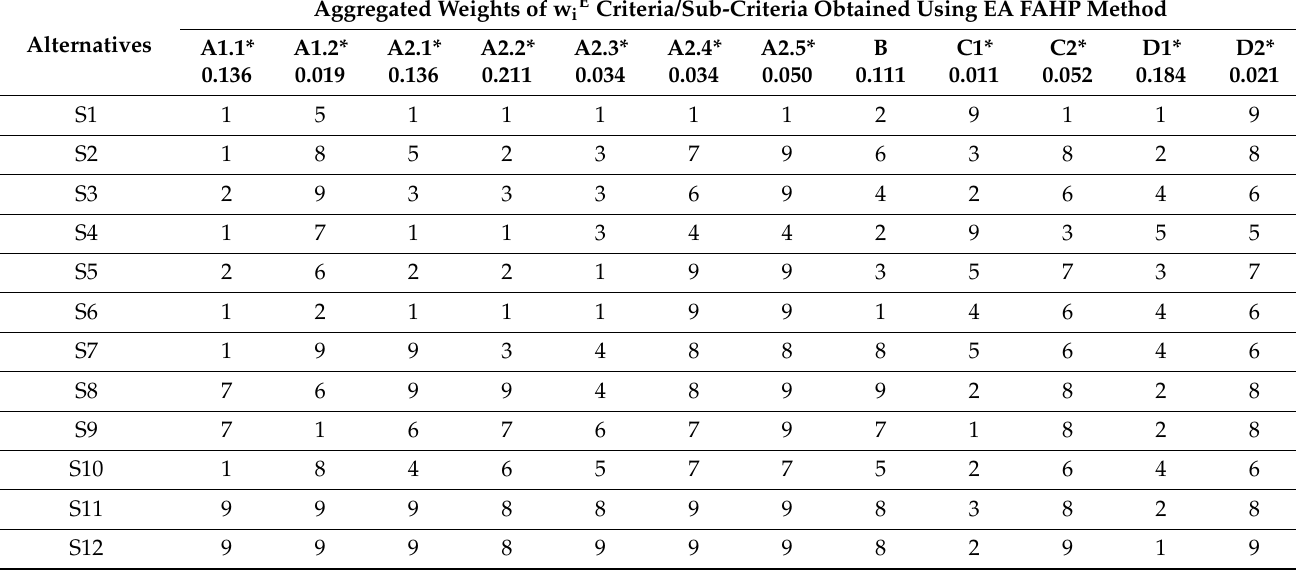
Table 7. Decision matrix for FuzzyTOPSIS (ranks given as modal values).